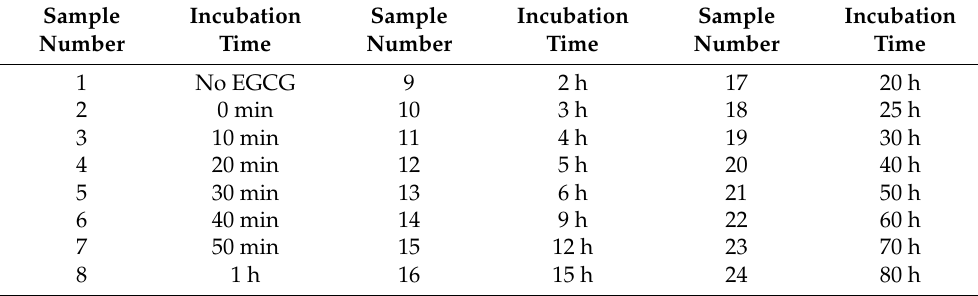
Table 1. EGCG sample incubation times and their numbering. Sample 1 did not contain EGCG and was used as a control, samples 2–24 contained 10 mM